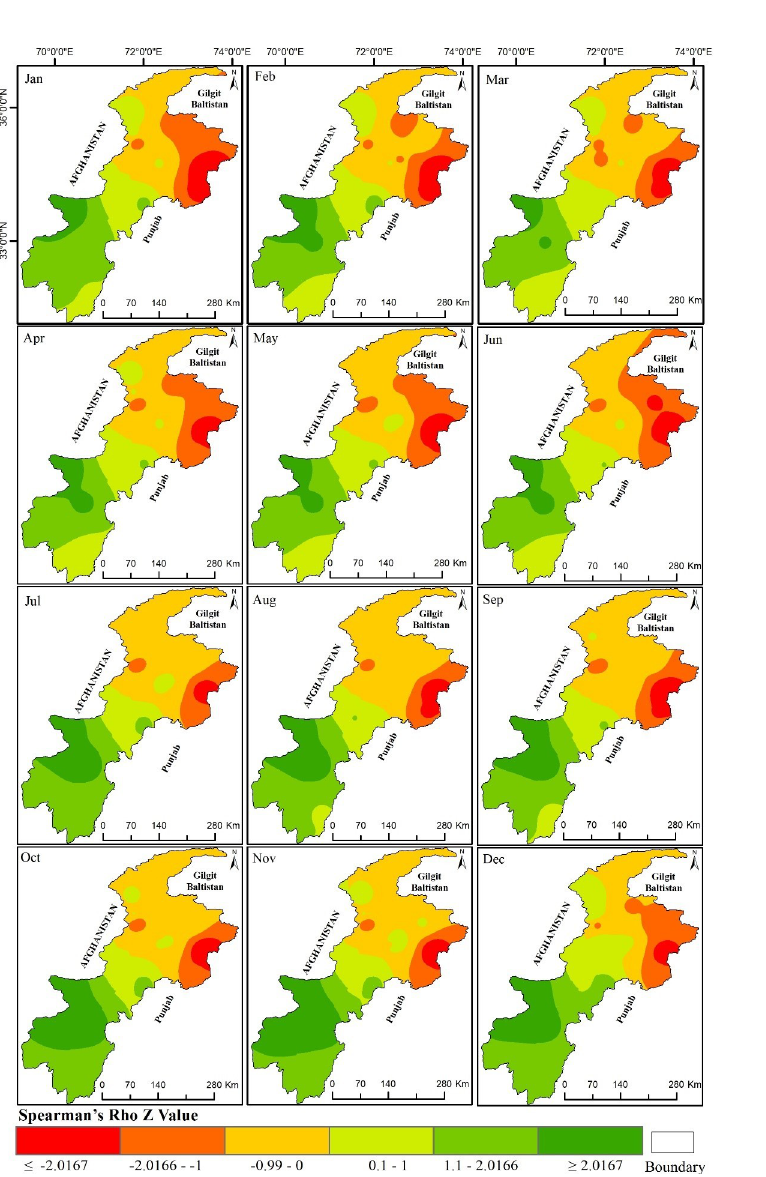
Fig 6. Spatial distribution Spearman’s Rho Z value for SPEI 12-month. (The Z Value of ± 2.0167 is the significant trend at a 95% confidence level).